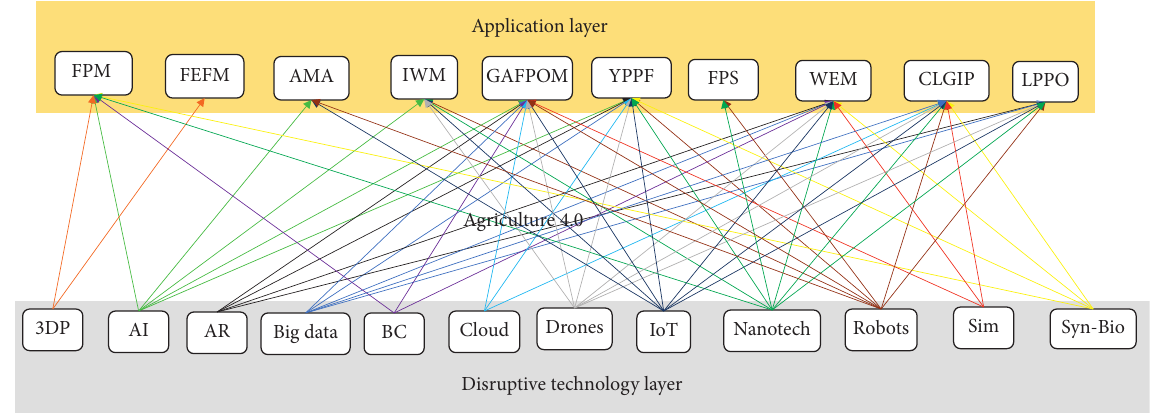
Figure 5: The convergence of disruptive technologies in agriculture and food systems. Table 7: Percentage convergence in agriculture and food application